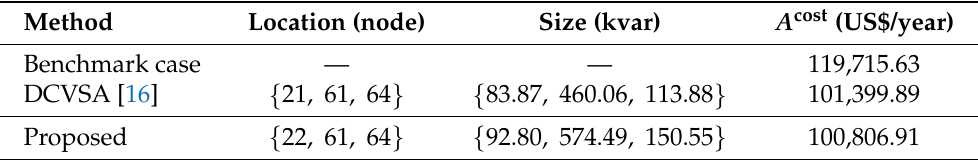
Table 6. Numerical results in the IEEE 69-bus system for the proposed and comparative methods.